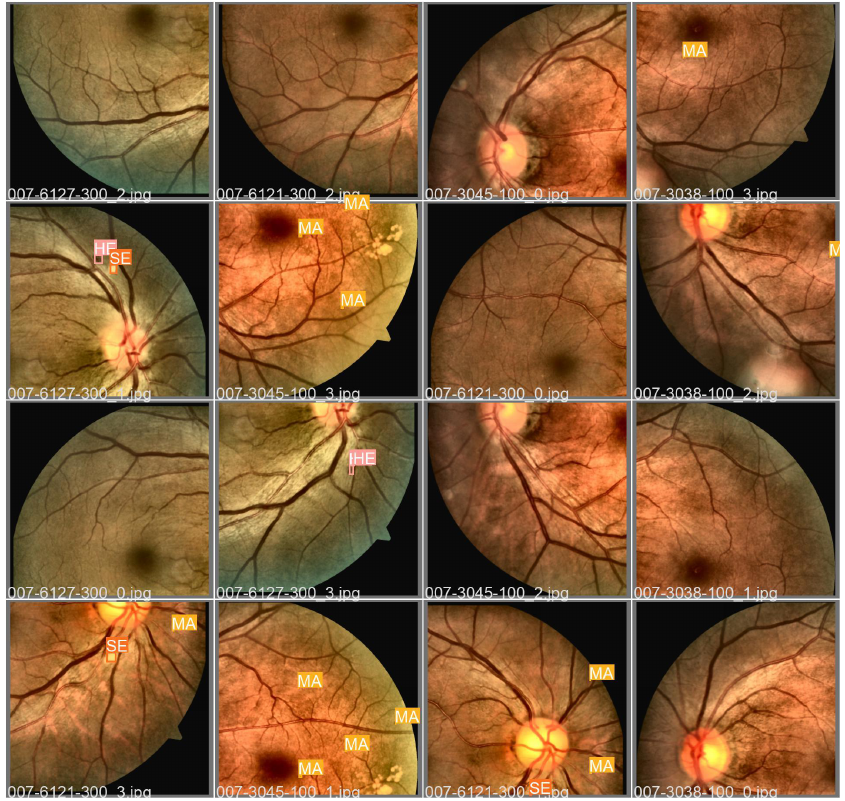
Figure 9. Batch example with fundus images of the Dataset for Diabetic Retinopathy (DDR) along with annotations ( Ground Truth ) of the fundus lesions after the pre-processing and data augmentation steps that were used to validate the proposed approach. MA, microaneurysms; HE, hemorrhages; SE, soft